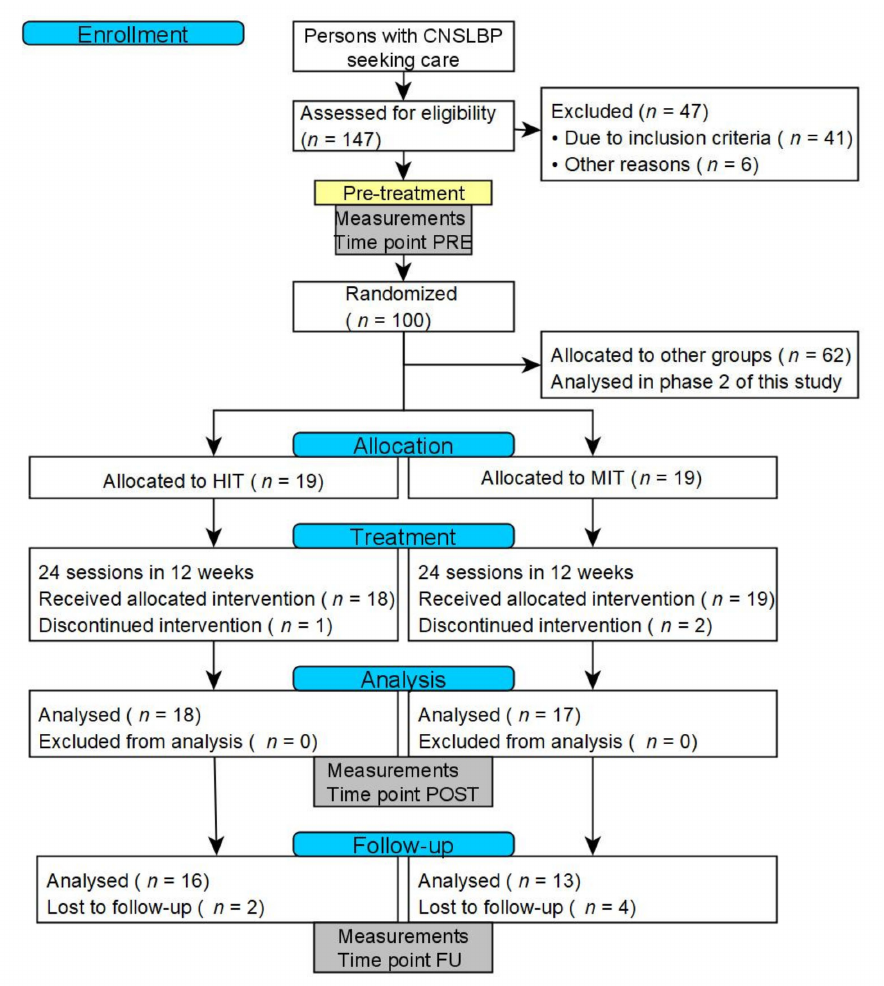
Figure 1. CONSORT flowchart of the research design. Abbreviations: CNSLBP: chronic nonspecific low back pain; HIT: High intensity training; MIT: moderate intensity